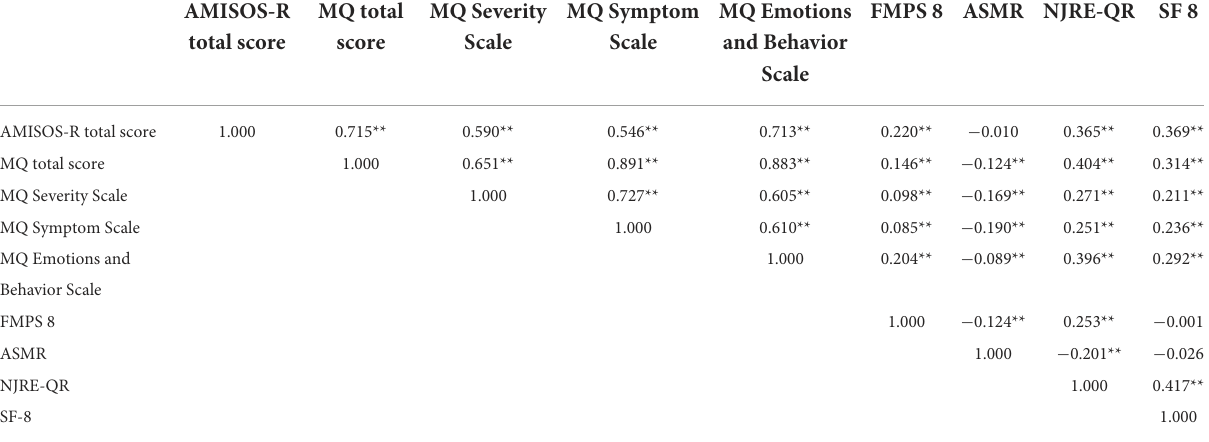
TABLE 3 Spearman correlations among misophonia scales and other clinical scales.